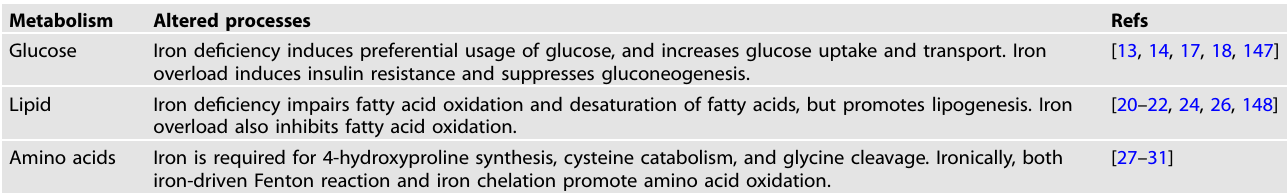
Table 1. Involvement of iron in the metabolism of glucose, lipid, and amino